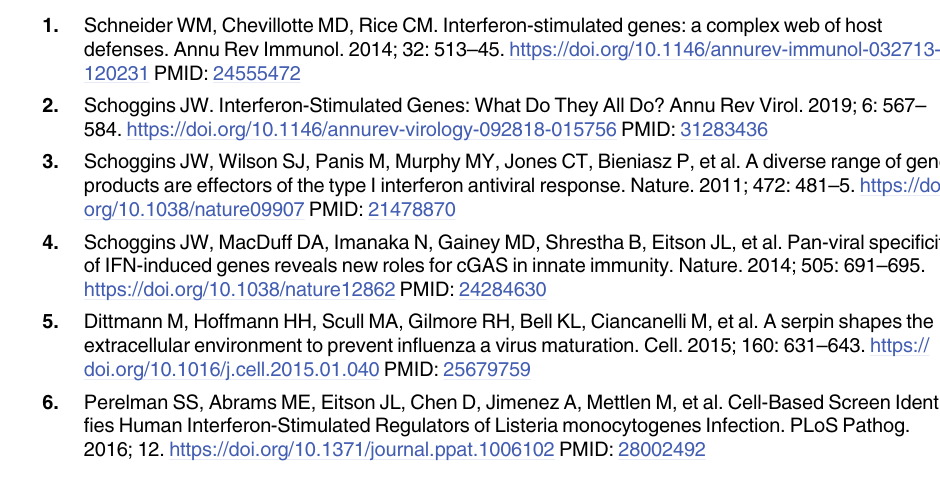
S6 Table. Validation experiment statistical testing p